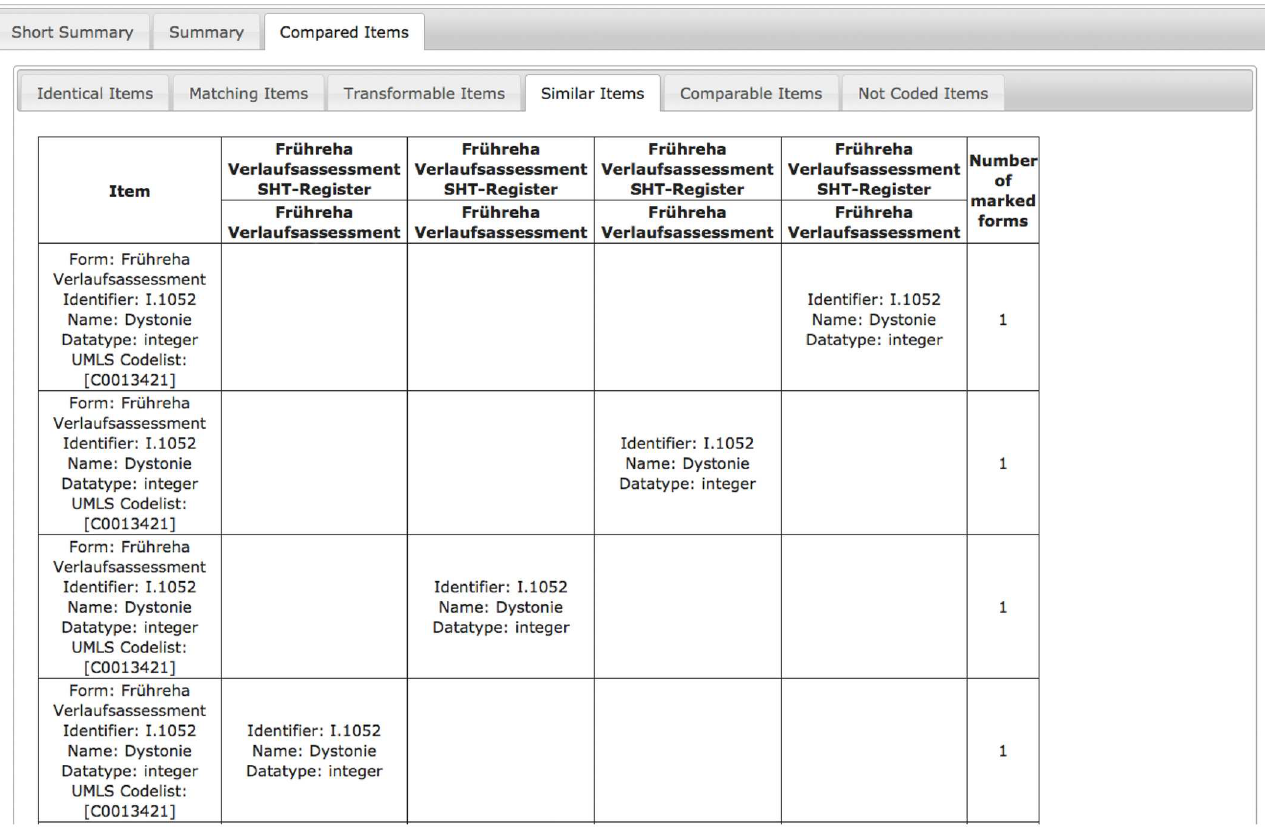
Fig 10. Comparison of 4 versions of a form showing the development of the item “Dystonie” (eng.